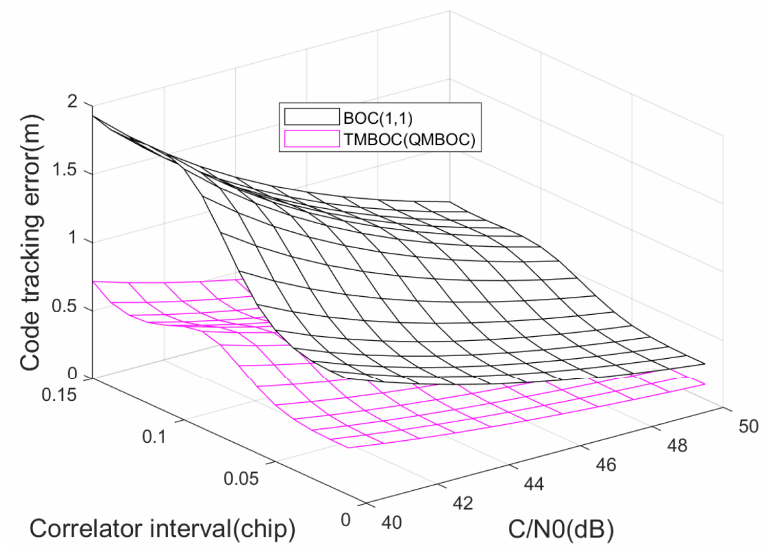
Figure 2. The noncoherent code-tracking error.